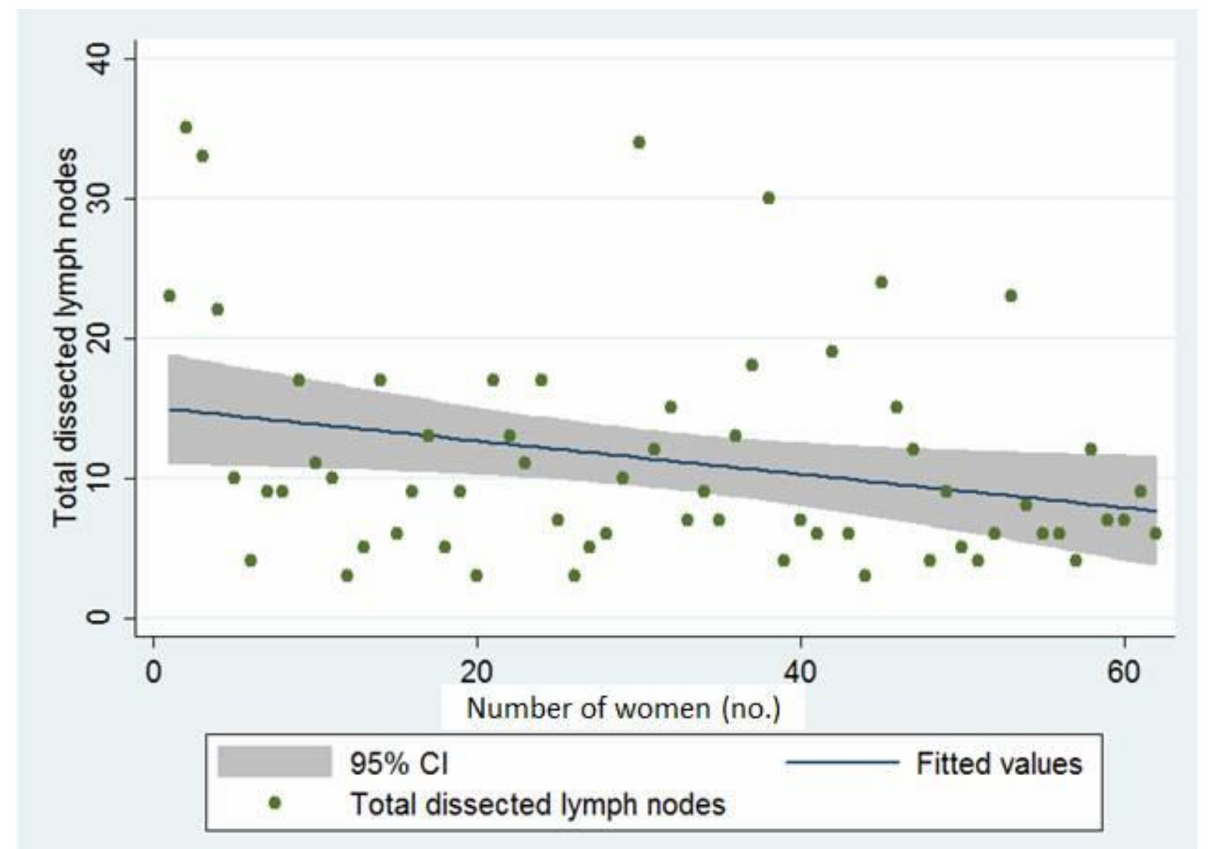
Figure 3. Total number of dissected pelvic lymph nodes versus the number of women across time in the sentinel lymph node group ( n = 62).